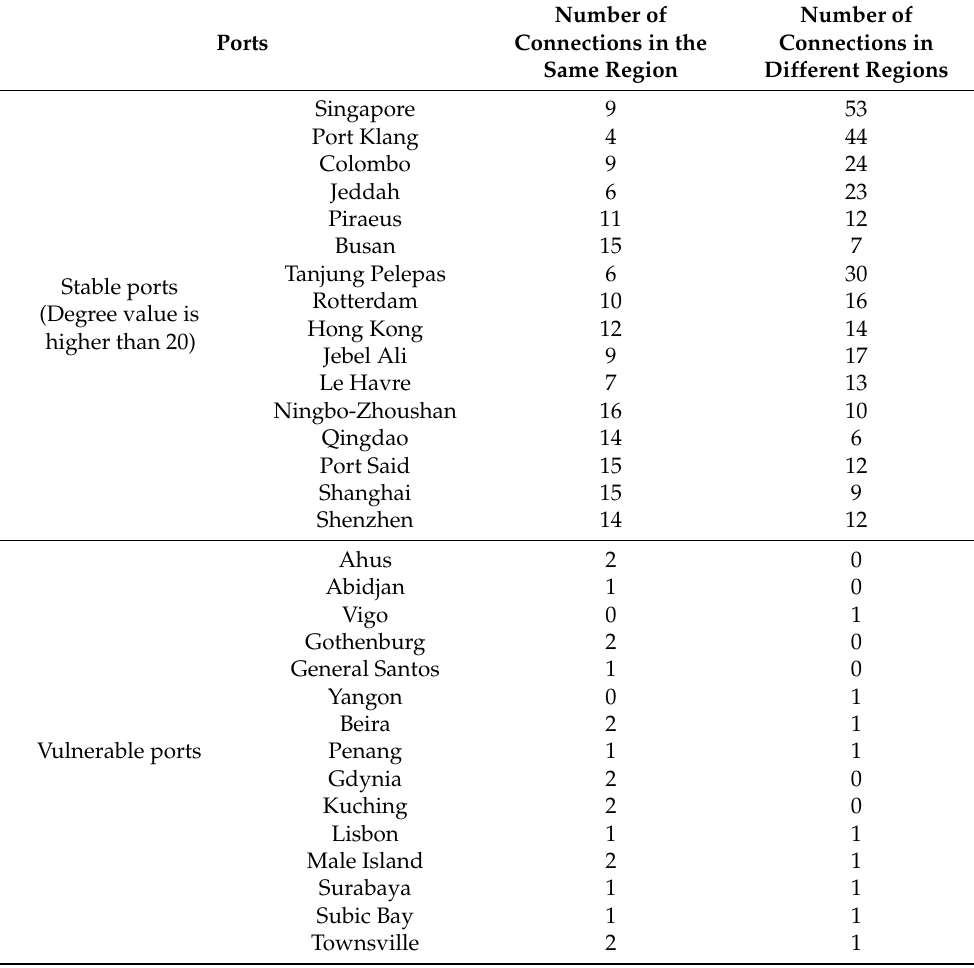
Table 3. Regional distribution of ports that are connected with vulnerable ports and stable ports. Ports